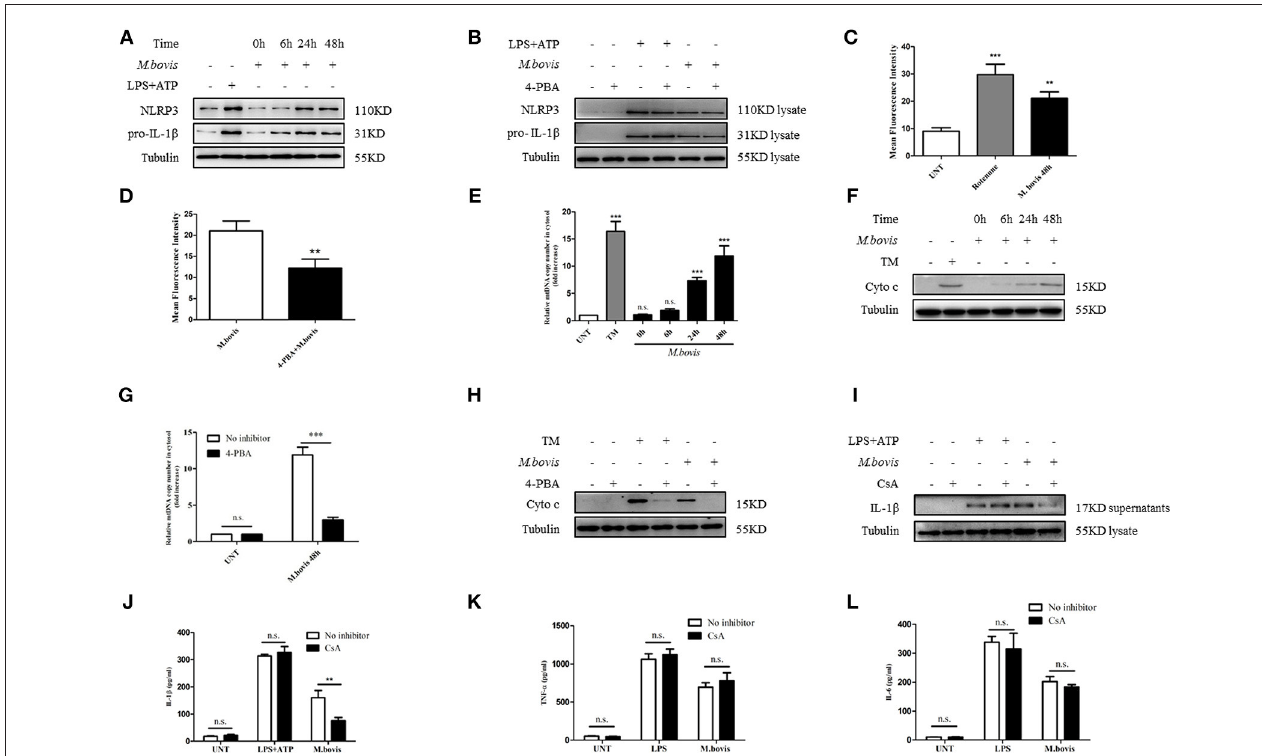
FIGURE 2 | ERS-induced mitochondrial dysfunction is involved in inflammasome activation. (A) Immunoblot analysis at different time-points of NLRP3 and pro-IL-1 β in lysates of BMDMs infected with M. bovis (MOI 10). (B) Immunoblot analysis of NLRP3 and pro-IL-1 β in lysates from BMDMs infected for 24h with M. bovis (MOI 10) in the presence or absence of 4-PBA. Control image is the same as Figure 1D . (C) ROS production measured at various time-points by flow cytometry in BMDMs infected with M. bovis (MOI 10). (D) ROS production was measured by flow cytometry in BMDMs infected for 48h with M. bovis (MOI 10) in the presence or absence of 4-PBA. (E) qPCR analysis of mtDNA release into the cytosol during M. bovis (MOI 10) infection. (F) Immunoblot analysis at different time-points of cytochrome c in cytosolic extracts of BMDMs infected with M. bovis (MOI 10). (G) qPCR analysis of mtDNA release into the cytosol in BMDMs treated with or without 4-PBA for 1h and then infected with M. bovis (MOI 10) for 48h. (H) Immunoblot analysis of cytochrome c in cytosolic extracts from BMDMs infected with M. bovis (MOI 10) for 48h in the absence or presence of 4-PBA. (I) IL-1 β immunoblot analysis of supernatants from BMDMs infected for 24h with M. bovis (MOI 10) in the presence or absence of CsA. (J) ELISA for IL-1 β detection in supernatants from BMDMs treated with or without CsA for 1h and then infected with M. bovis (MOI 10) for 24h. Control image is the same to Figure 1E . ELISA for (K) TNF- α and (L) IL-6 quantification in supernatants from BMDMs treated with or without CsA for 1h and then infected with M. bovis (MOI 10) for 24h. Control image is the same to Figures 1H,I . LPS + ATP, positive control for inflammasome activation, 200ng/ml, and 1mM, respectively; LPS, positive control for TNF- α and IL-6 production, 200ng/ml; 4-PBA, 4-phenyl butyric acid, ERS inhibitor, 5mM; UNT, untreated; rotenone, positive control for ROS production, 40 µ M; TM, tunicamycin, positive control for ERS-induced mitochondrial damage, 10 µ g/mL; CsA, cyclosporine A, inhibitor of MPTP opening, 10 µ M; siNLRP3, silencing RNA for NLRP3, 50nM; siAIM2, silencing RNA for AIM2, 50nM; siCon, non-targeting control siRNA, 50nM. MOI, multiplicity of infection. For (C,E)